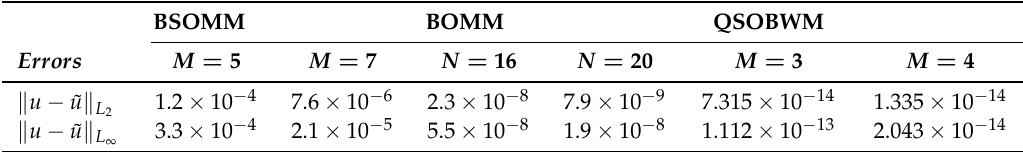
Table 6. The L 2 errors and L ∞ errors of QSOBWM, B-spline operational matrix method (BSOMM) (in [12]), and Bernstein operational matrix method (BOMM) (in [11]) for Example